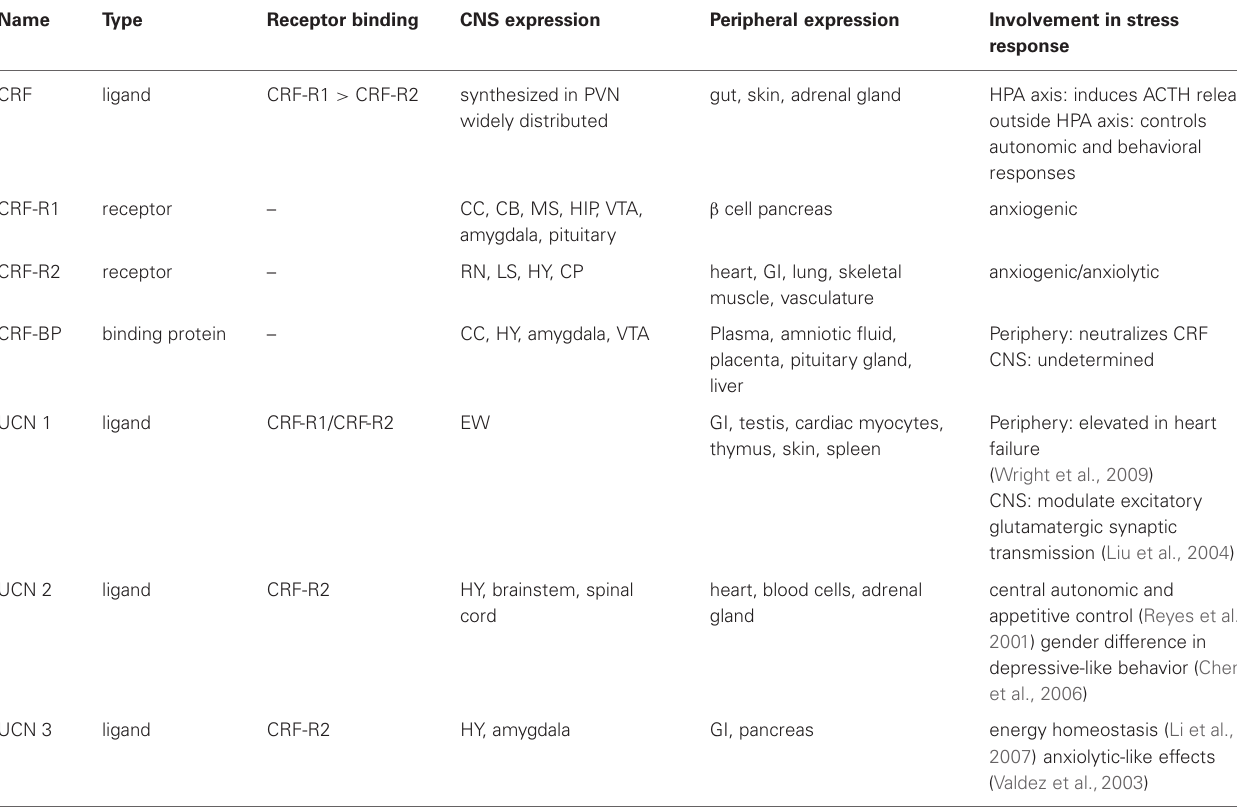
Table 1 | Corticotropin Releasing Factor (CRF)